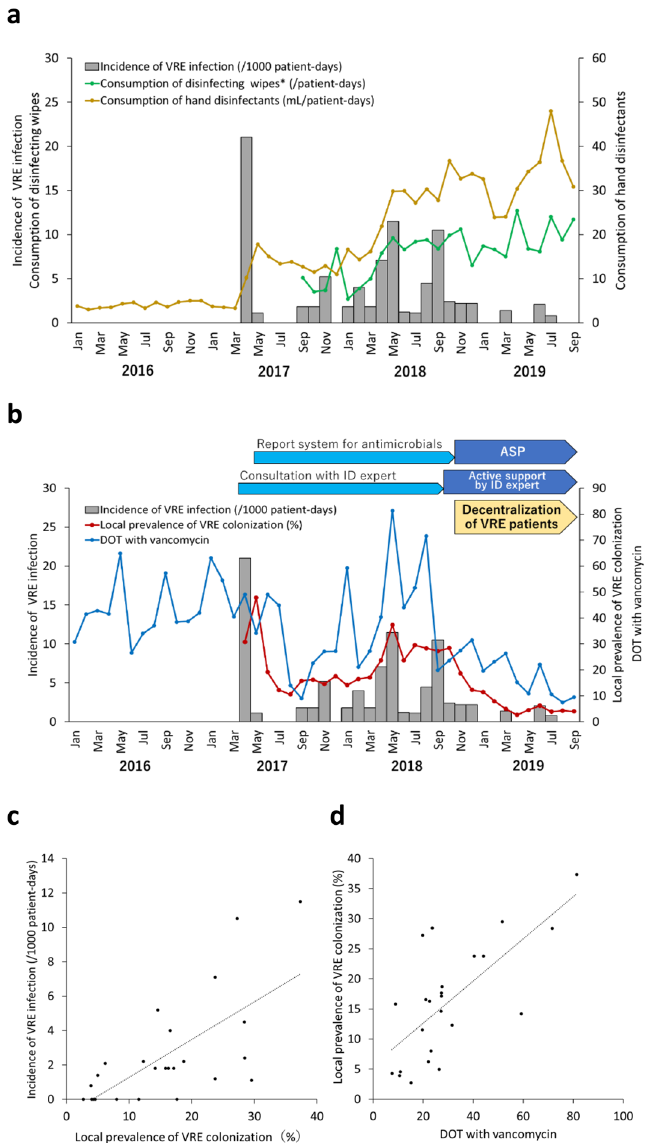
Figure 8. Incidence of vancomycin-resistant enterococci (VRE) infection and implemented infection control measures in ward A. ( a ) Consumption of hand disinfectants and disinfecting wipes. *Data before September 2017 were not available. ( b ) Local prevalence of VRE colonization and days of therapy (DOT) with vancomycin. ASP antimicrobial stewardship program, ID infectious disease. ( c ) Correlation between the incidence of VRE infection and local prevalence of VRE colonization. ( d ) Correlation between local prevalence of VRE colonization and DOT with